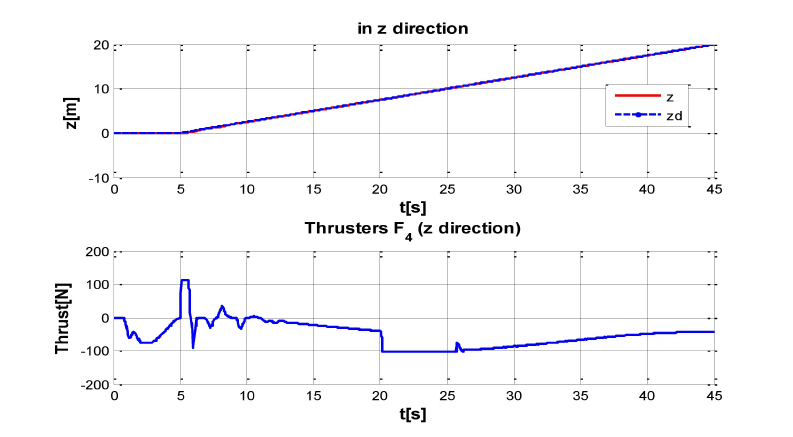
Figure 7. Behavior of the system in z-coordinate with perturbations up and (down) control signal of thruster